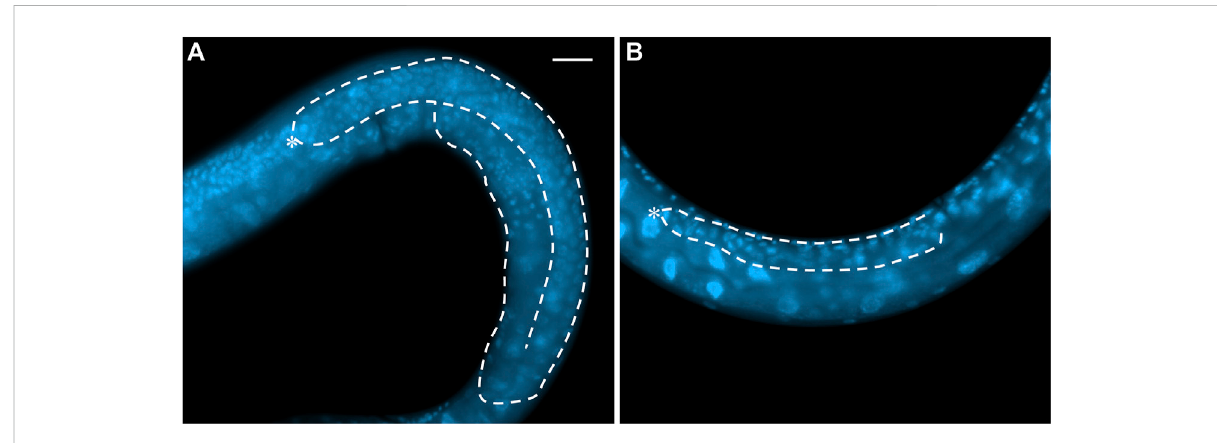
FIGURE 3 WholemountDAPIstainingof (A) anL4wild-typehermaphroditeand (B) aGLP-1/Notchsignalingmutant(actualgenotype glp-1(bn18ts) grown at 25 ° C). White dash line shows the outline of one gonad arm. Asterisk: DTC. Scale bar: 20